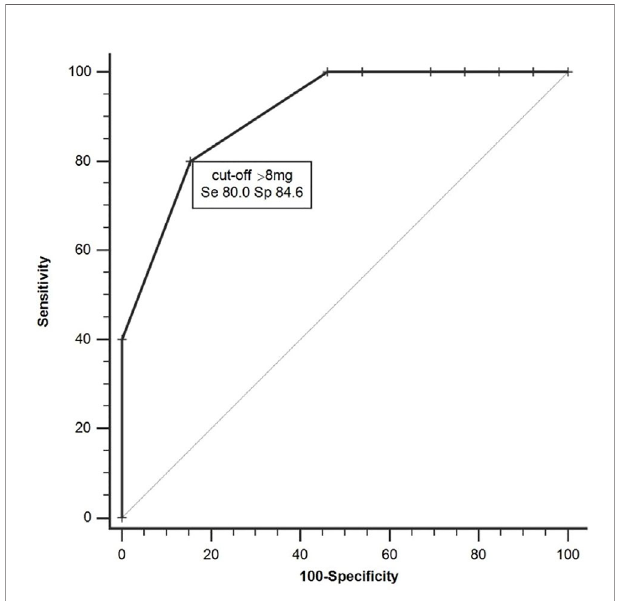
FIGURE 2 | Signi fi cantly better outcome in the benzodiazepines (BZD − ) group on day 3 (p = 0.04) and day 7 (p = 0.02) revealed by repeated measures analysis of variance